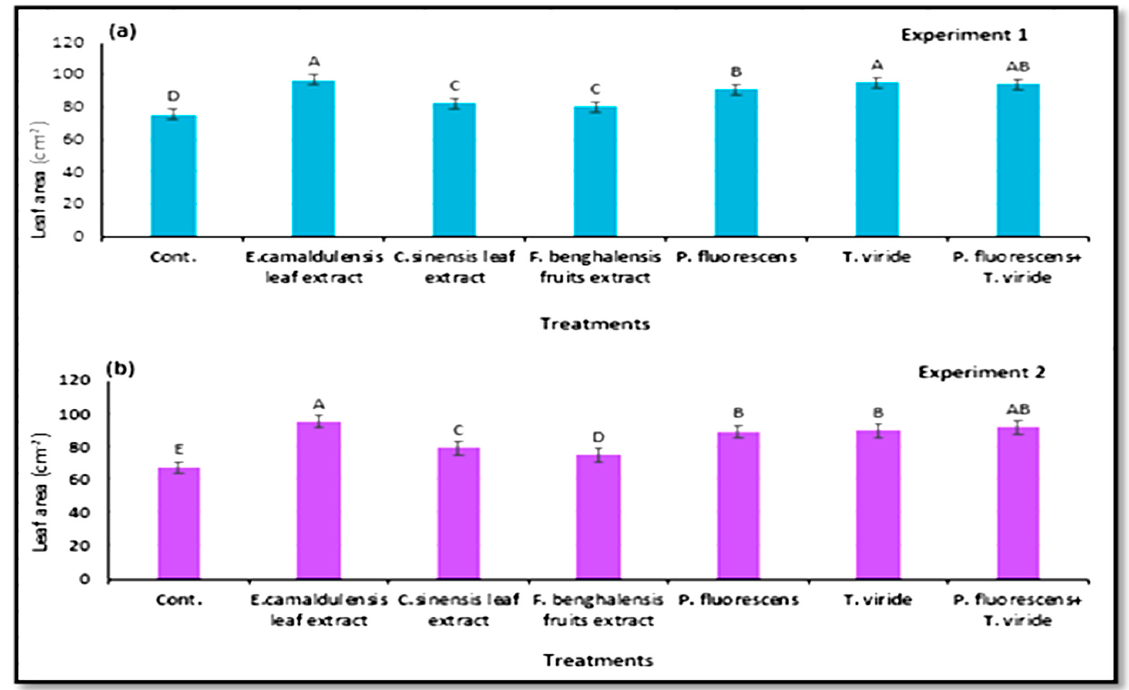
Figure 7. Leaf area (means ± S.E) of zucchini as affected by the natural plant extracts and microbial antagonists. Letters in Figure indicate the means ± S.E of treatments with the same letter/s were not significantly different according to LSD at 0.05 level of probability. ( a ) Experiment 1; ( b ) experiment 2.